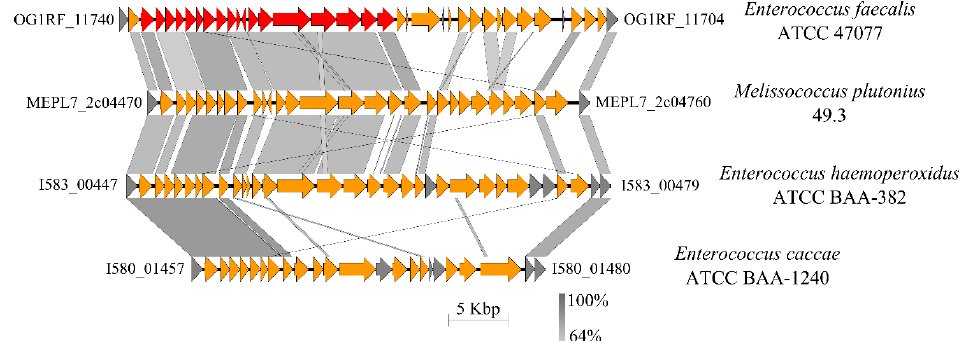
Figure 7. Comparison of a gene cluster of M. plutonius with gene clusters of Enterococci encoding Epa. ORFs labeled with locus tags represent the corresponding ends of the shown genome segments. ORFs related to the epa -locus are marked in orange, and ORFs encoding Epa of Enterococcus faecalis are depicted in red. Conserved hypothetical proteins are shown in gray. The gene cluster shows highest sequence similarity to Epa of E. faecalis and Enterococcus haemoperoxidus .